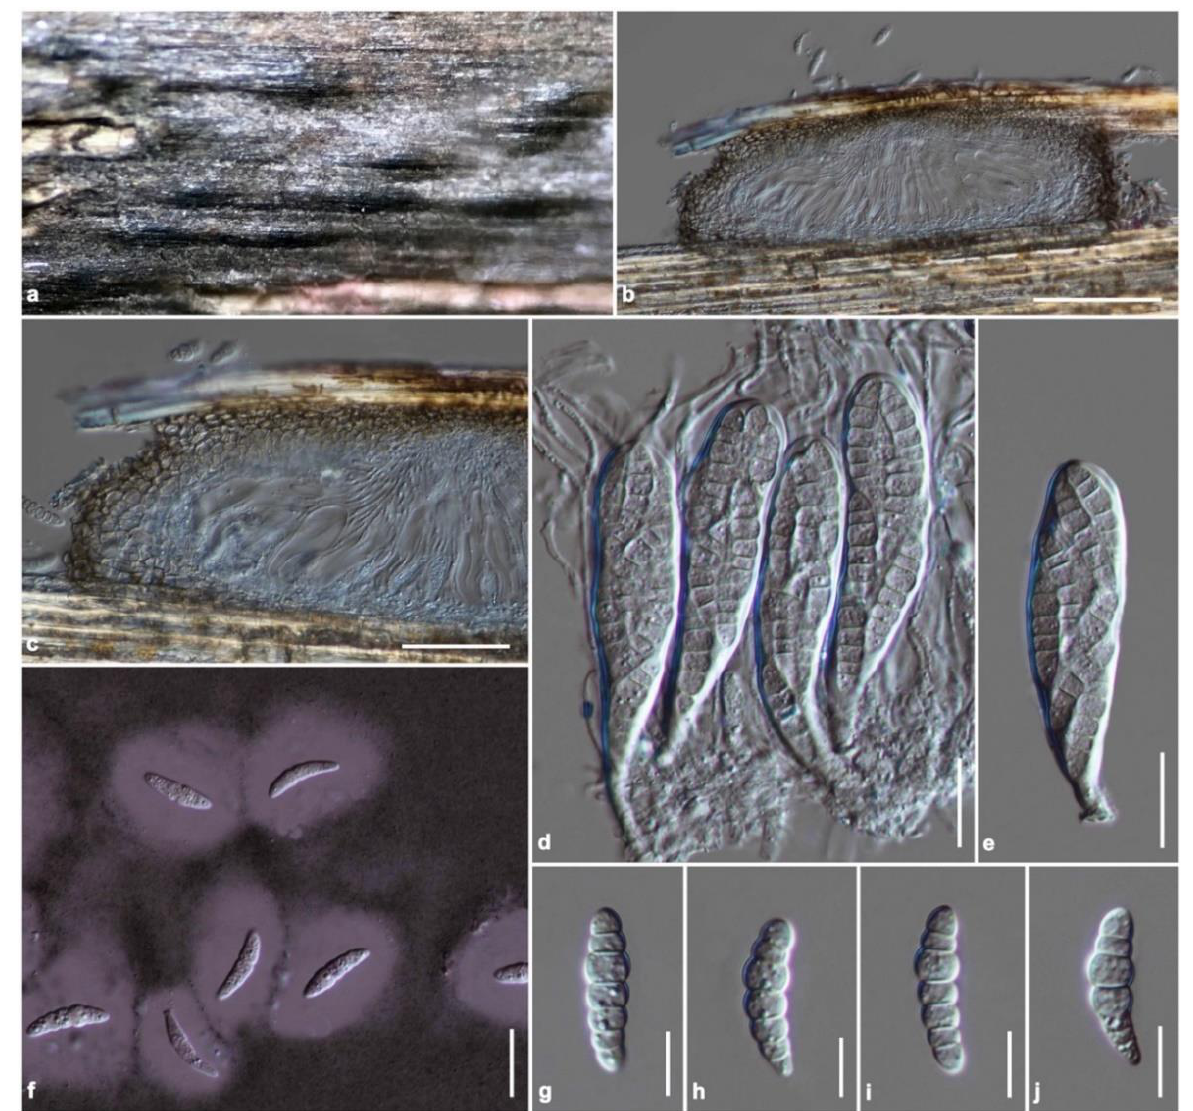
Figure 6. Paramultiseptospora bambusae (KUN-HKAS 122241, holotype). ( a ) The appearance of ascomata on host substrate; ( b ) Vertical section of ascoma; ( c ) Peridium; ( d ) Asci embedded in cellular pseudoparaphyses; ( e ) Ascus; ( f ) Ascospores stained with Indian ink showing a thick mucilaginous sheath surrounded ascospores; ( g – j ) Ascospores. Scale bars: ( b ) = 100 μm, ( c ) = 50 μm, ( d – f ) = 20 μm, ( g – j ) = 10 μm.